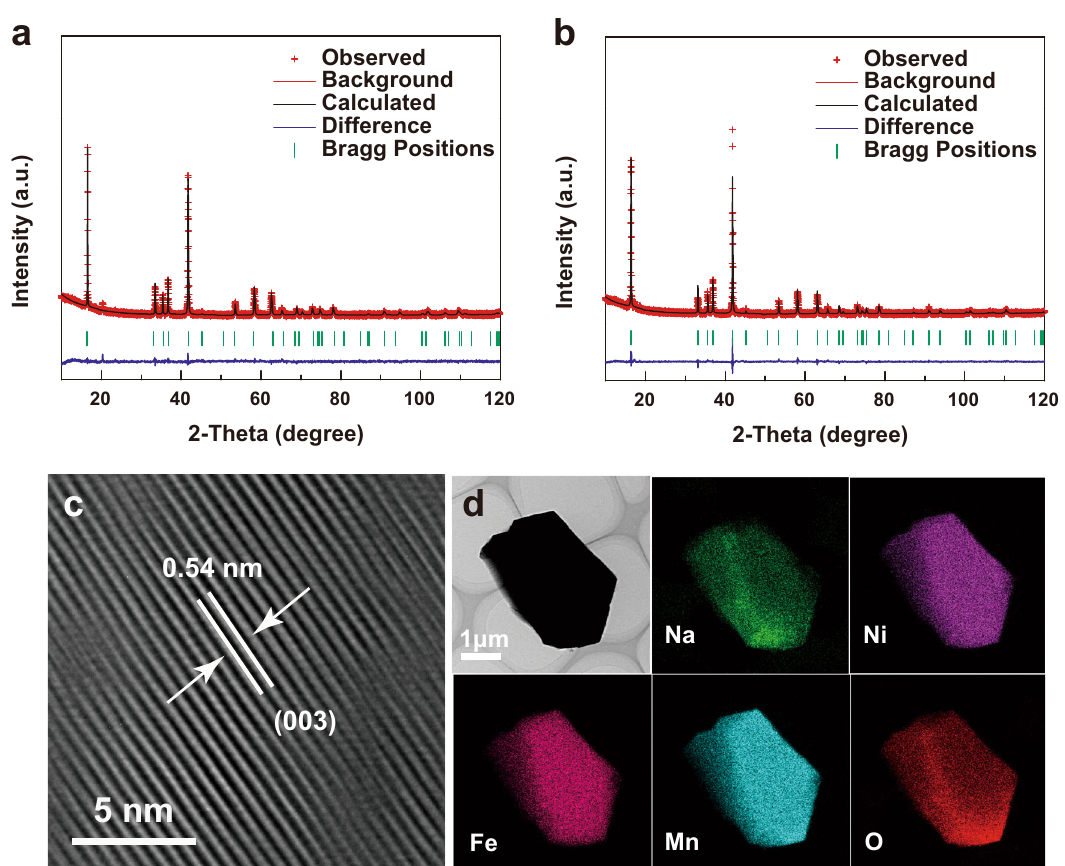
Fig. 3 Physicochemical measurements and analyses of the cathode active material powders. XRD and Rietveld re fi nement results of NLNFM ( a ) and NLNFMB ( b ), respectively. HRTEM images of (003) crystal planes ( c ) and EDS maps of NLNFMB ( d optimal species. In Supplementary Fig. 8, XRD patterns show no impurities in NaLi 1/9 Ni 2/9 Fe 2/9 Mn 4/9 B 1/100 O 2 (NLNFMB0.01) while some impurities with the small peaks around 17° appear in